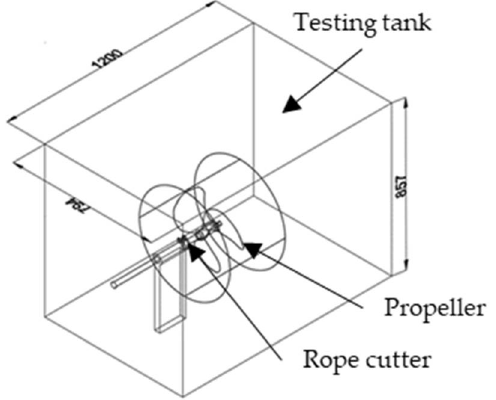
Figure 1. 3D model geometry.